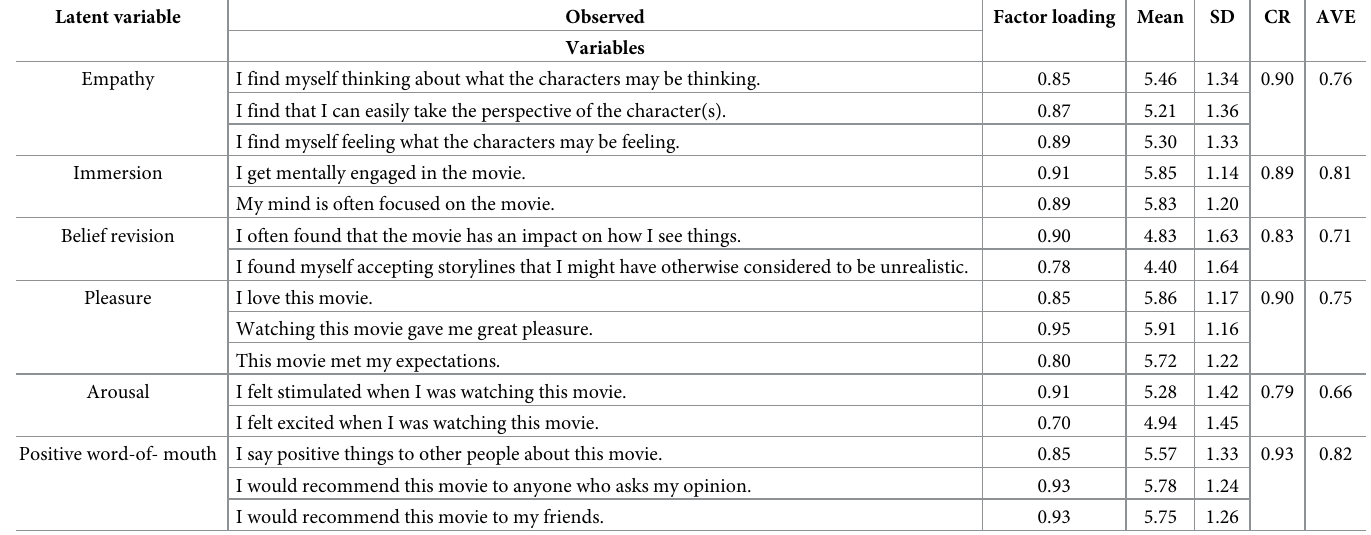
Table 1. Results of the internal reliability and convergent validity